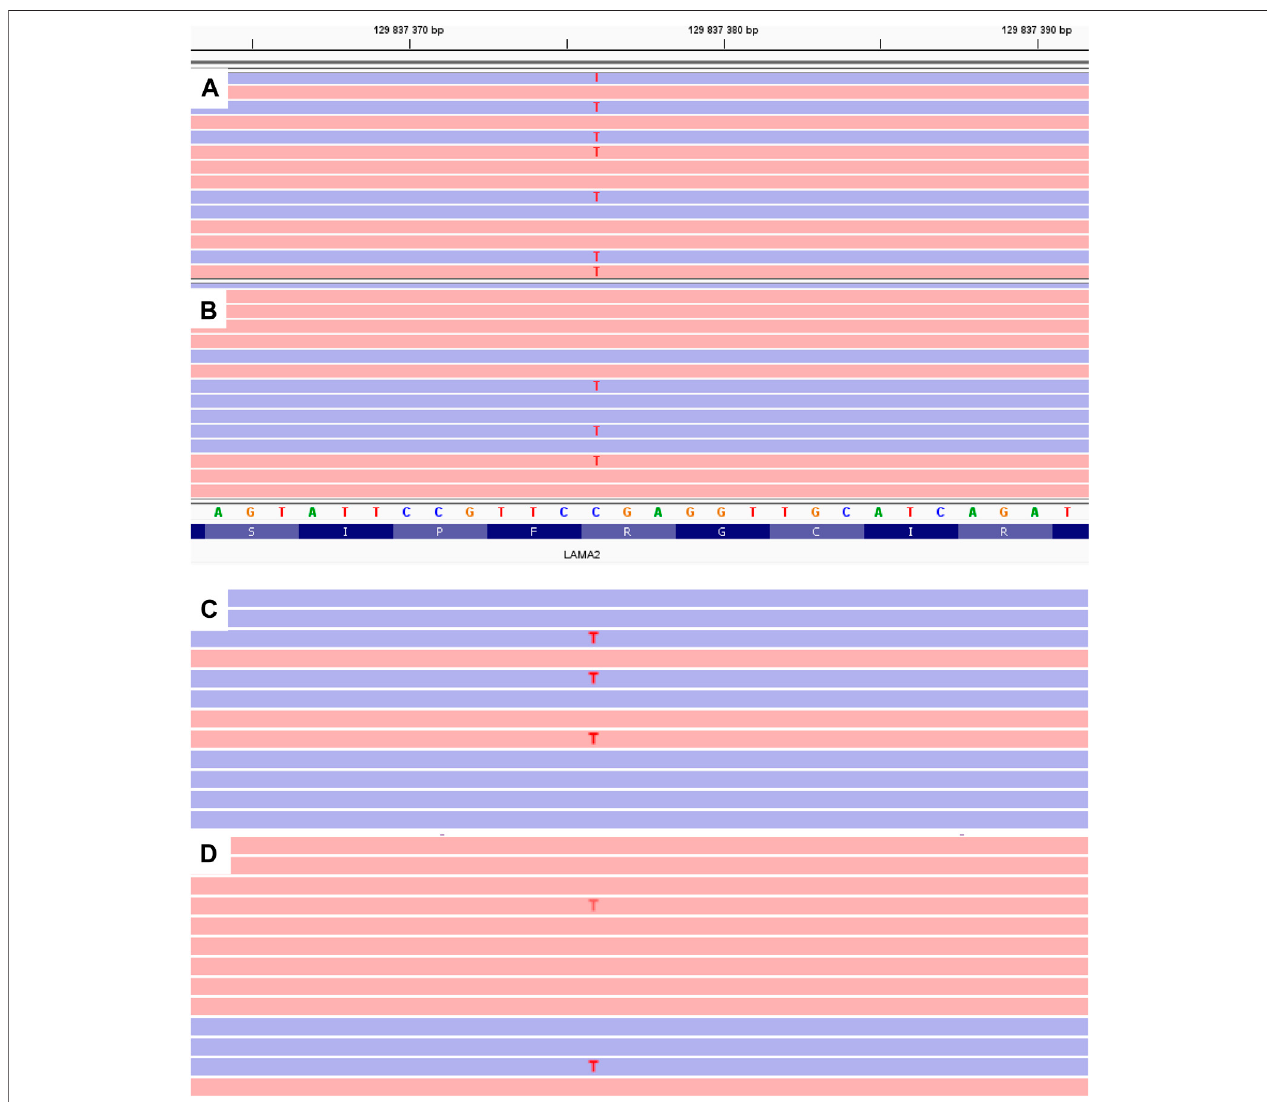
FIGURE3| MPSresults of LAMA2 exon65 forthe proband (A) and his father (B – D) . B-genomicDNA extracted from peripheralblood lymphocytes.C- genomic DNA extracted from the buccal epithelium. C - genomic DNA extracted from the father ’ s semen.